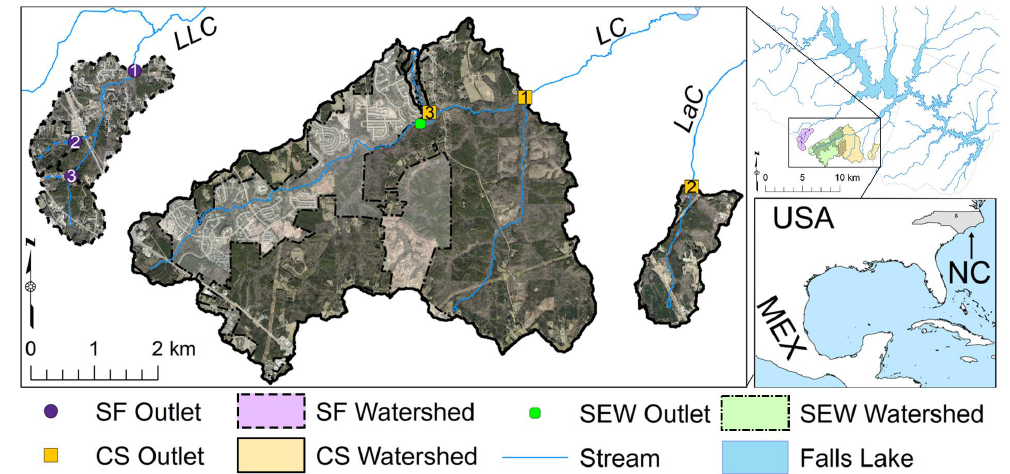
Figure 1. Watershed delineation map for the 3 conventional septic (CS), 3 sand filter (SF), and sewered (SEW) watershed. LC = Lick Creek; LLC = Little Lick Creek; and LaC = Laurel Creek.